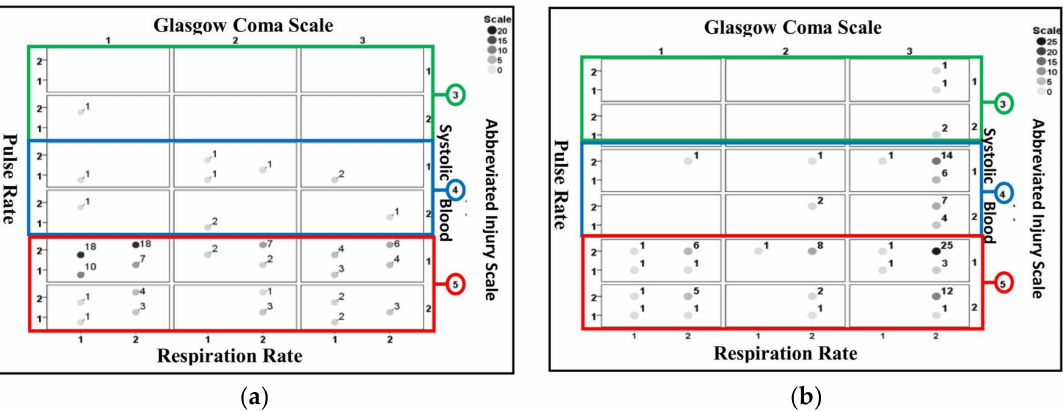
Figure 8. Identification results for PSD for non-surviving cases included in the validation dataset. ( a ) Correctly identified cases ( b ) misidentified cases. The values next to the circles indicate the number of associated